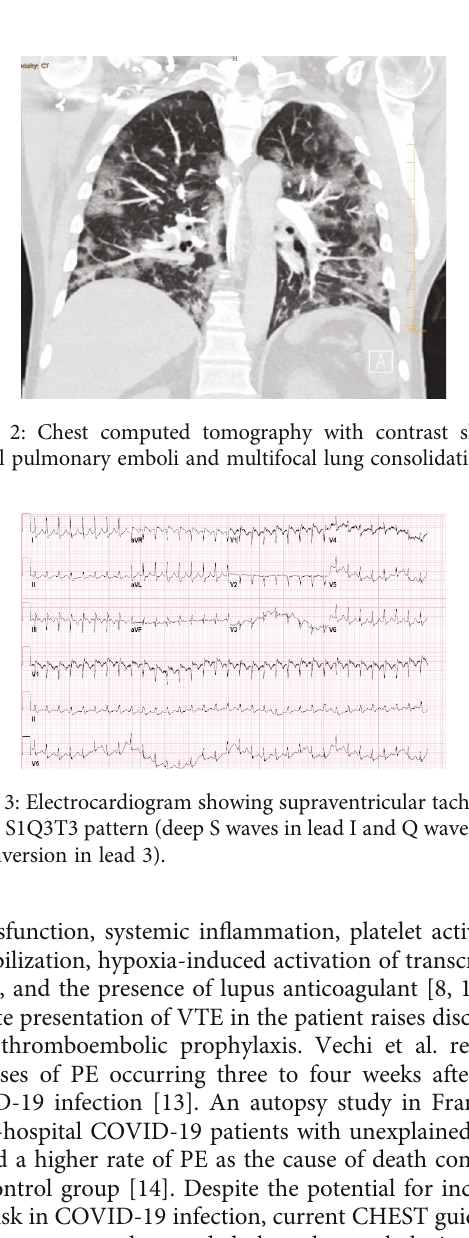
Figure 1: Chest X-ray showing bilateral lung opacities.